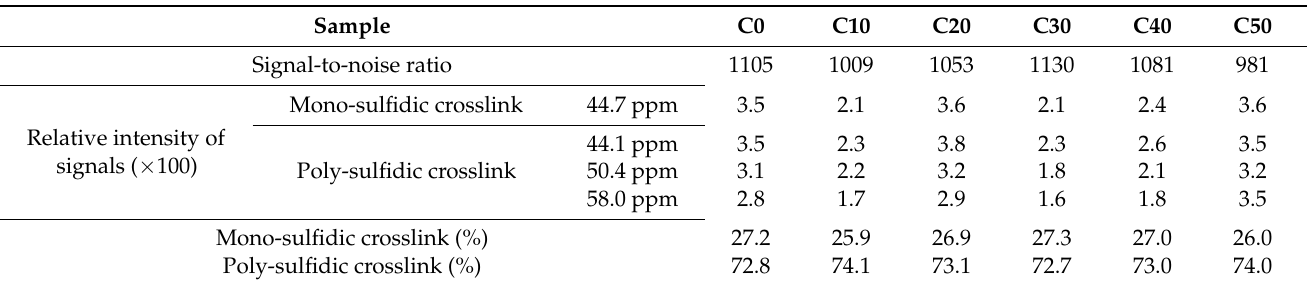
Table 2. 13 C-NMR data of CSDPF/NR